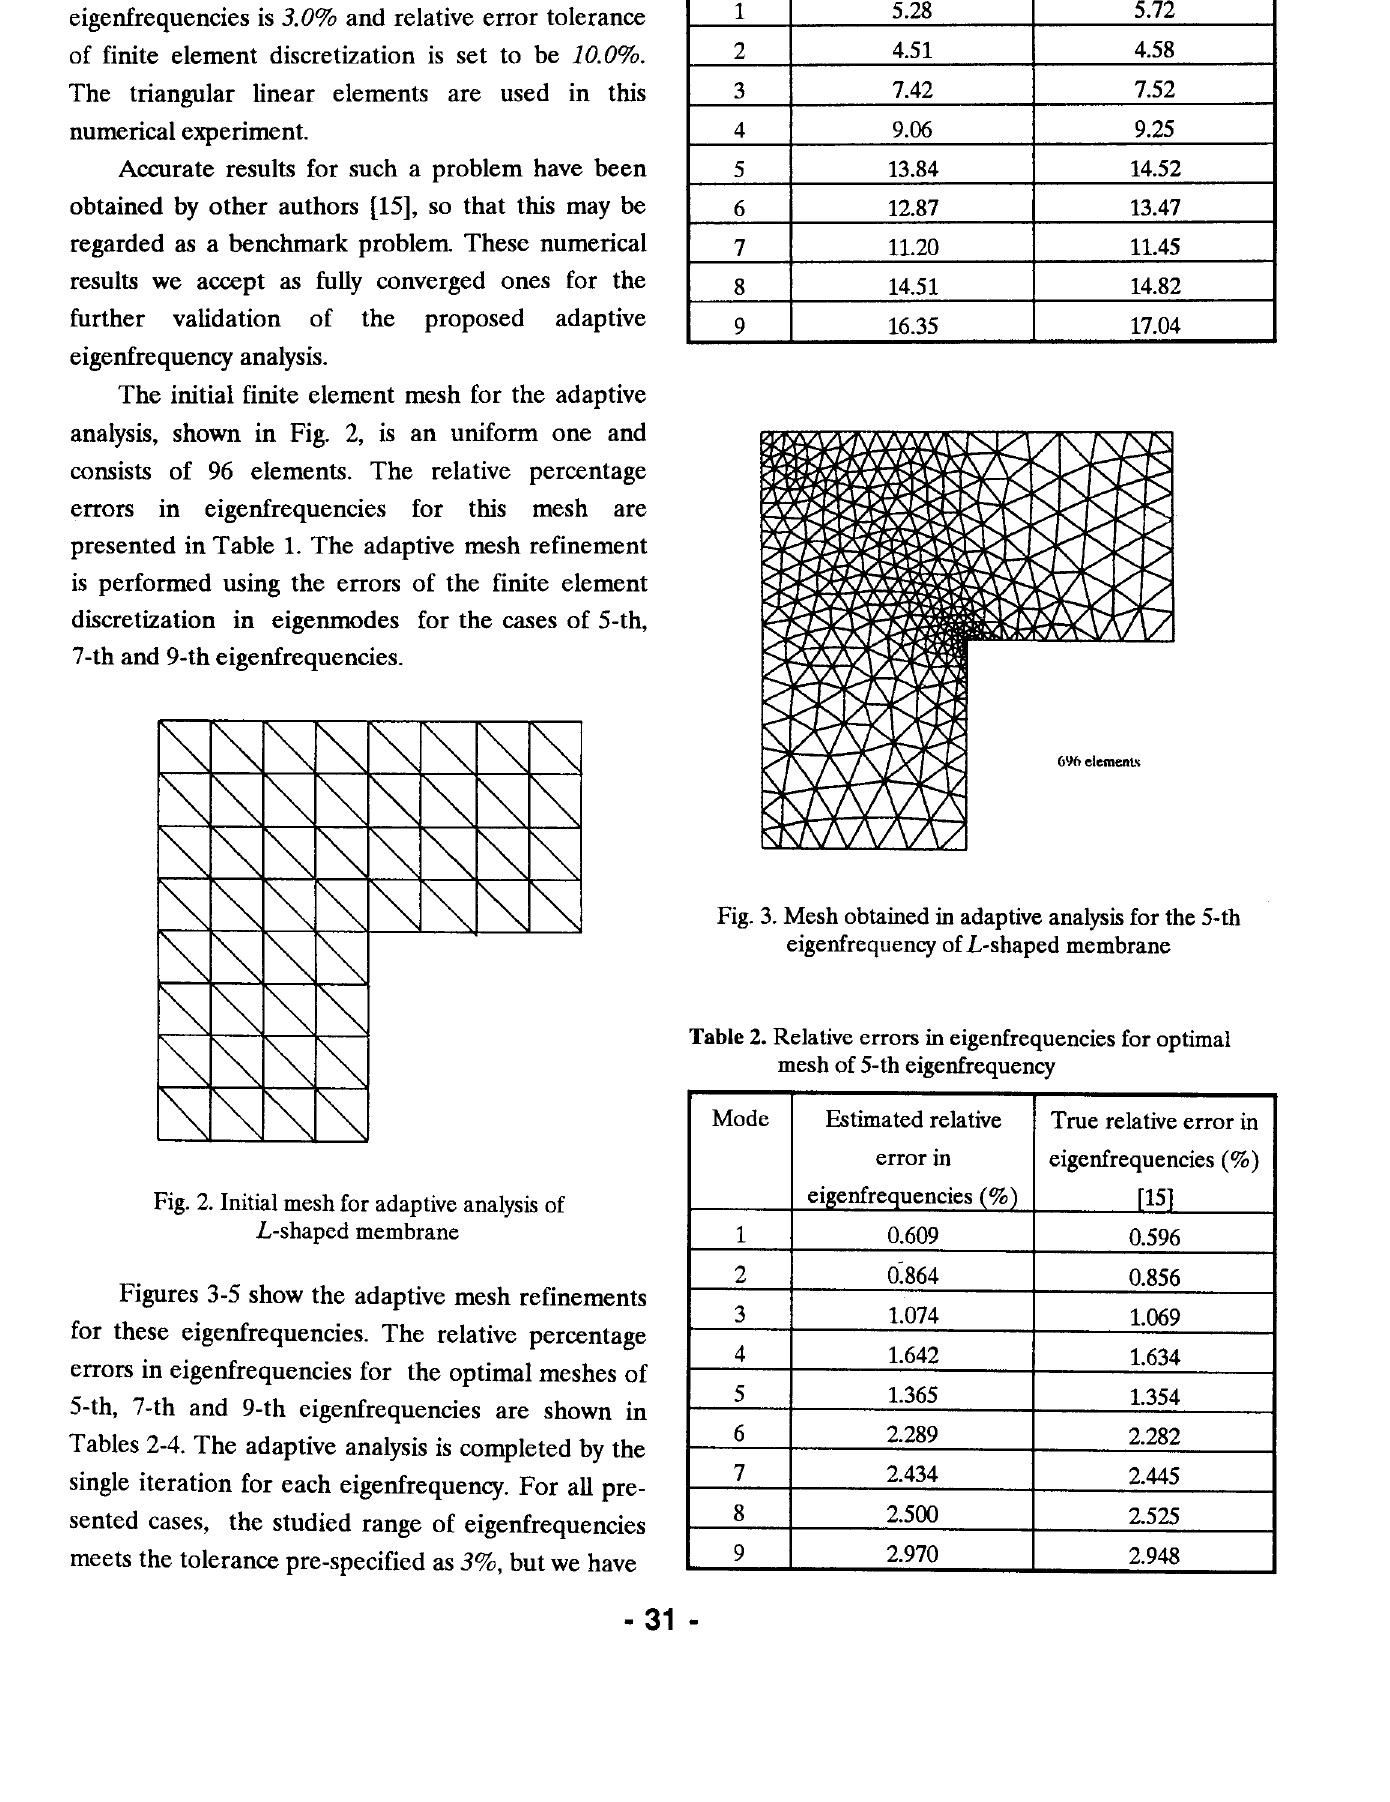
Fig. 2. Initial mesh for adaptive analysis of L-shaped membrane